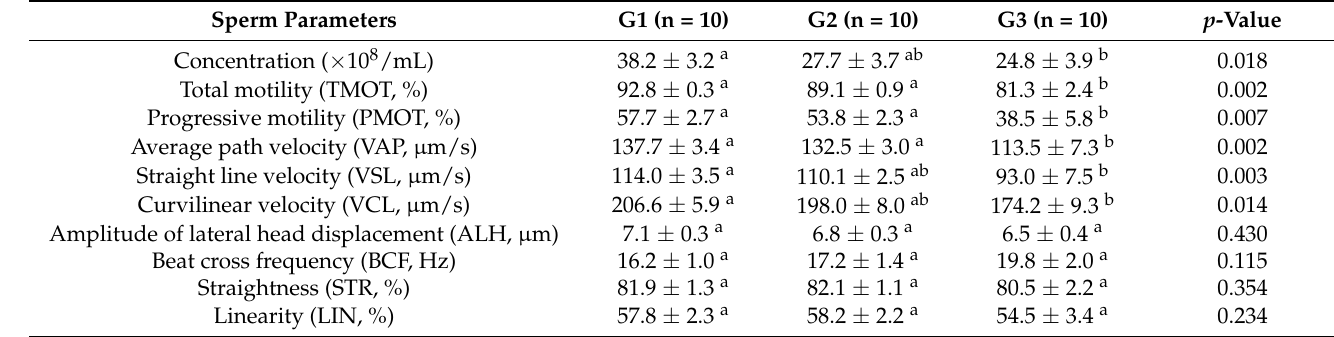
Table 1. Motion parameters of the epididymal spermatozoa of dogs ( Canis lupus familiaris ) in different age groups (G1: 12–41 months old; G2: 42–77 months old; G3: 78–132 months